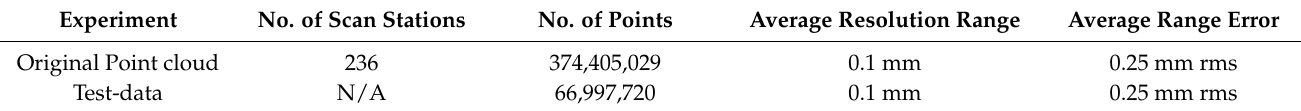
Table 1. The number of scan stations, the total number of points, and registration precision.